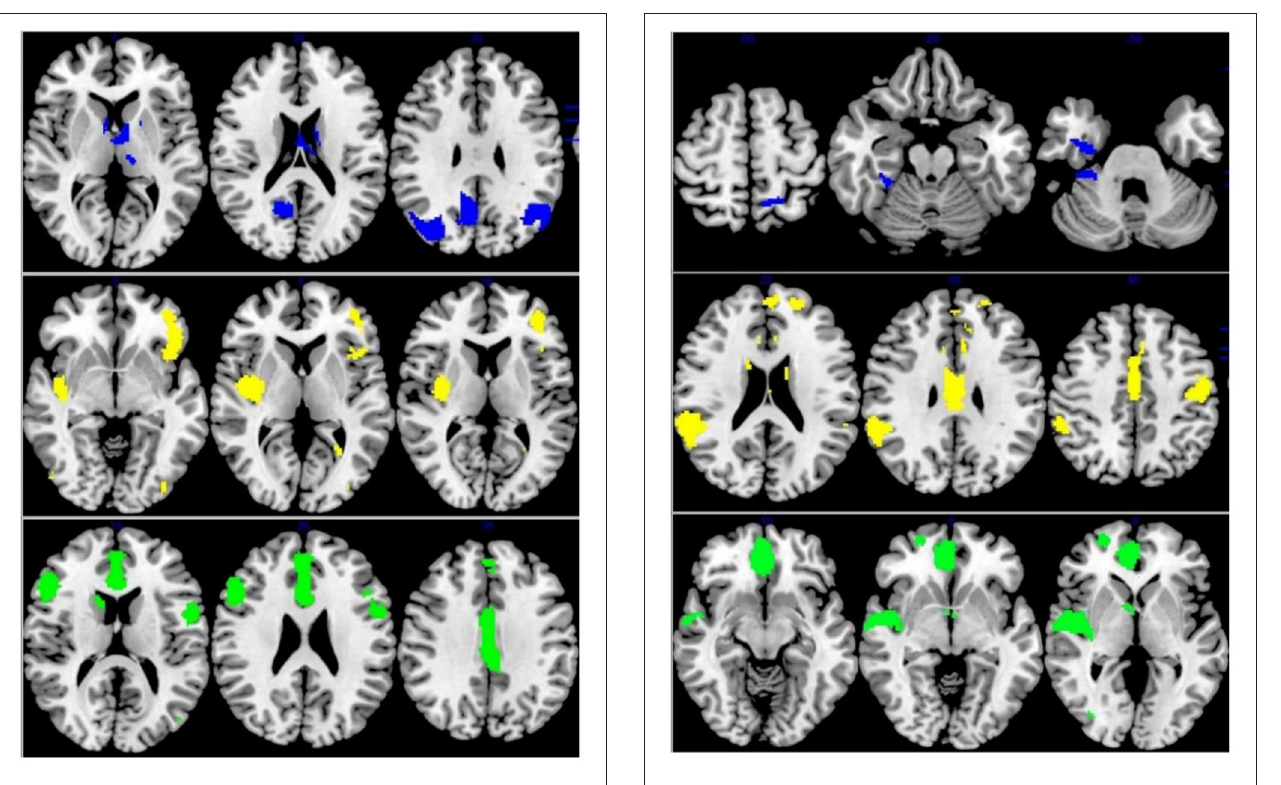
FIGURE 4 | Multimodel analysis in the IGD. Blue: increased GMV and increased activation; Yellow: decreased GMV and functional connection; Green: decreased GMV and increased activation.